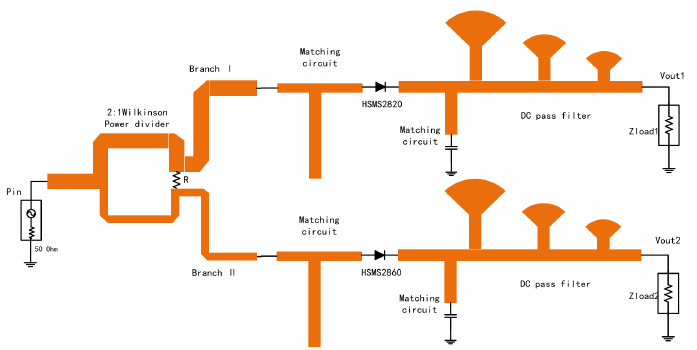
Figure 10. The schematic diagram of the 2:1 dual RF-DC microwave rectifier circuit.